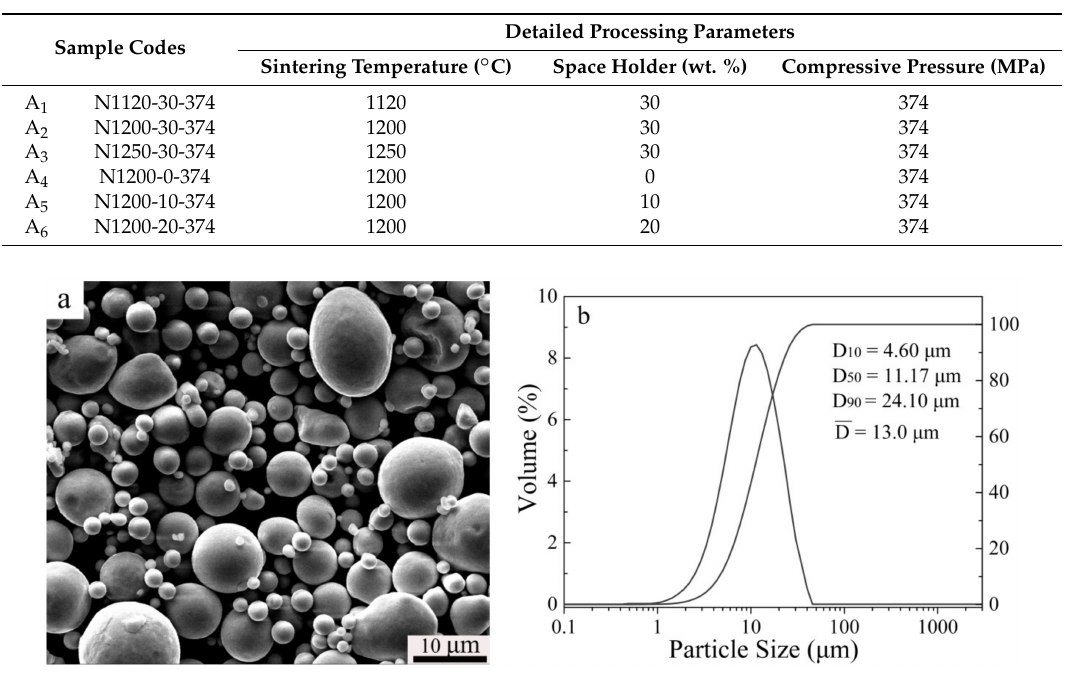
Figure 1. SEM morphology ( a ) and particle size distribution ( b ) of the as-received